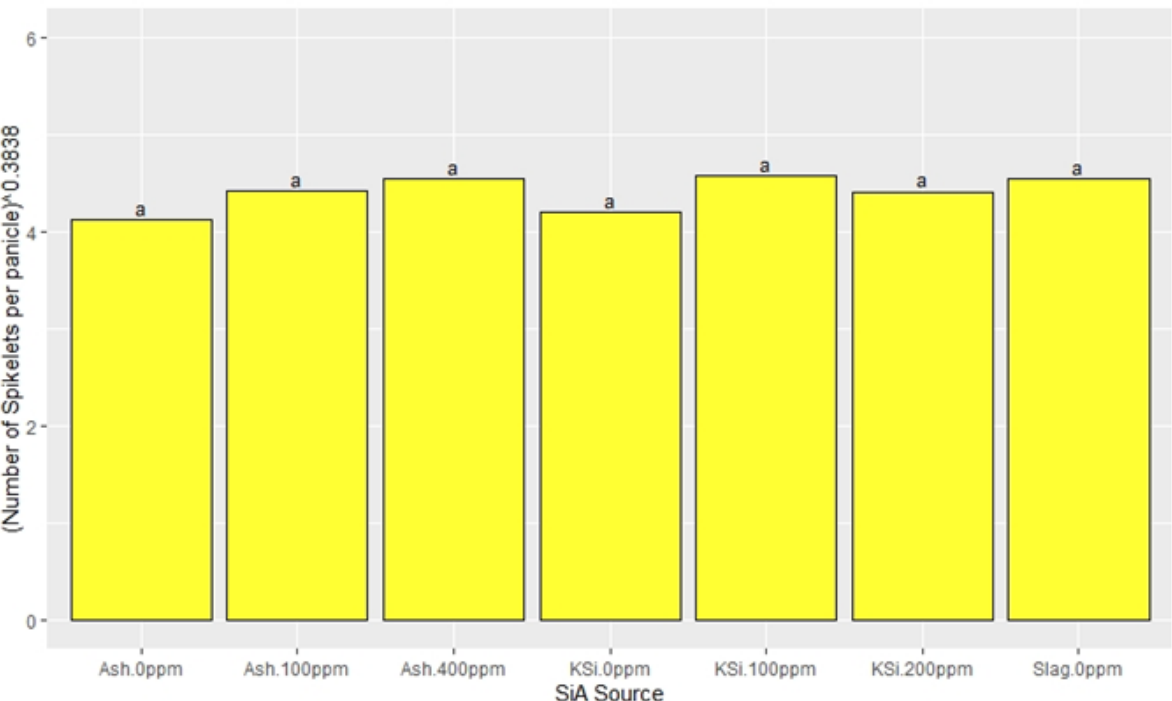
Figure 10 . Statistical summary of ( Number of Spikelets per panicle ) 0.3838 . Significance levels were obtained with Tukey test, α = 0.05. Ash stands for rice husk ash; KSi, for potassium silicate and Slag, for ladle furnace slag.